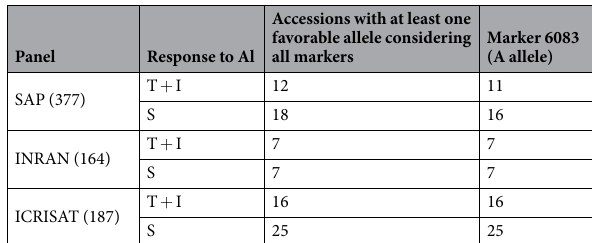
Table 1. Number of Al tolerant and intermediate (T + I), and Al sensitive (S) accessions with at least one favorable Alt SB allele considering joint selection with all markers or harboring the favorable (A) allele at marker 6083. The total number of accessions in each panel is shown after the panel